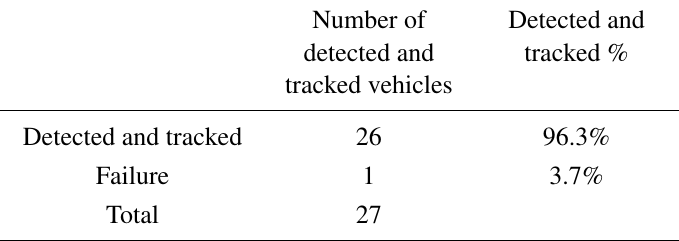
Table 7. Results of vehicle